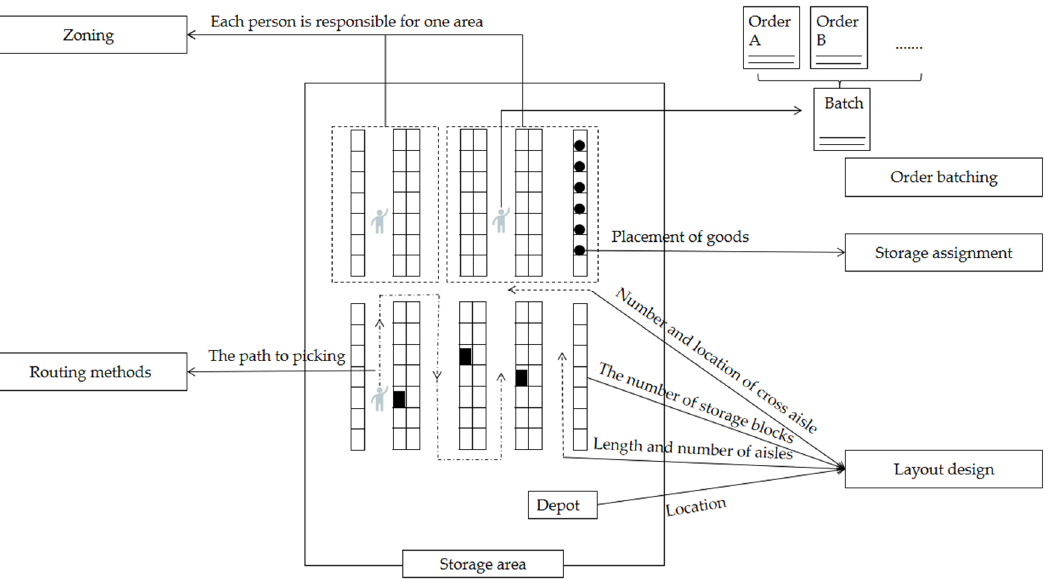
Figure 4. Function diagram of order-picking strategy (Taking the “picker-to-parts” picking system as an example [18]).